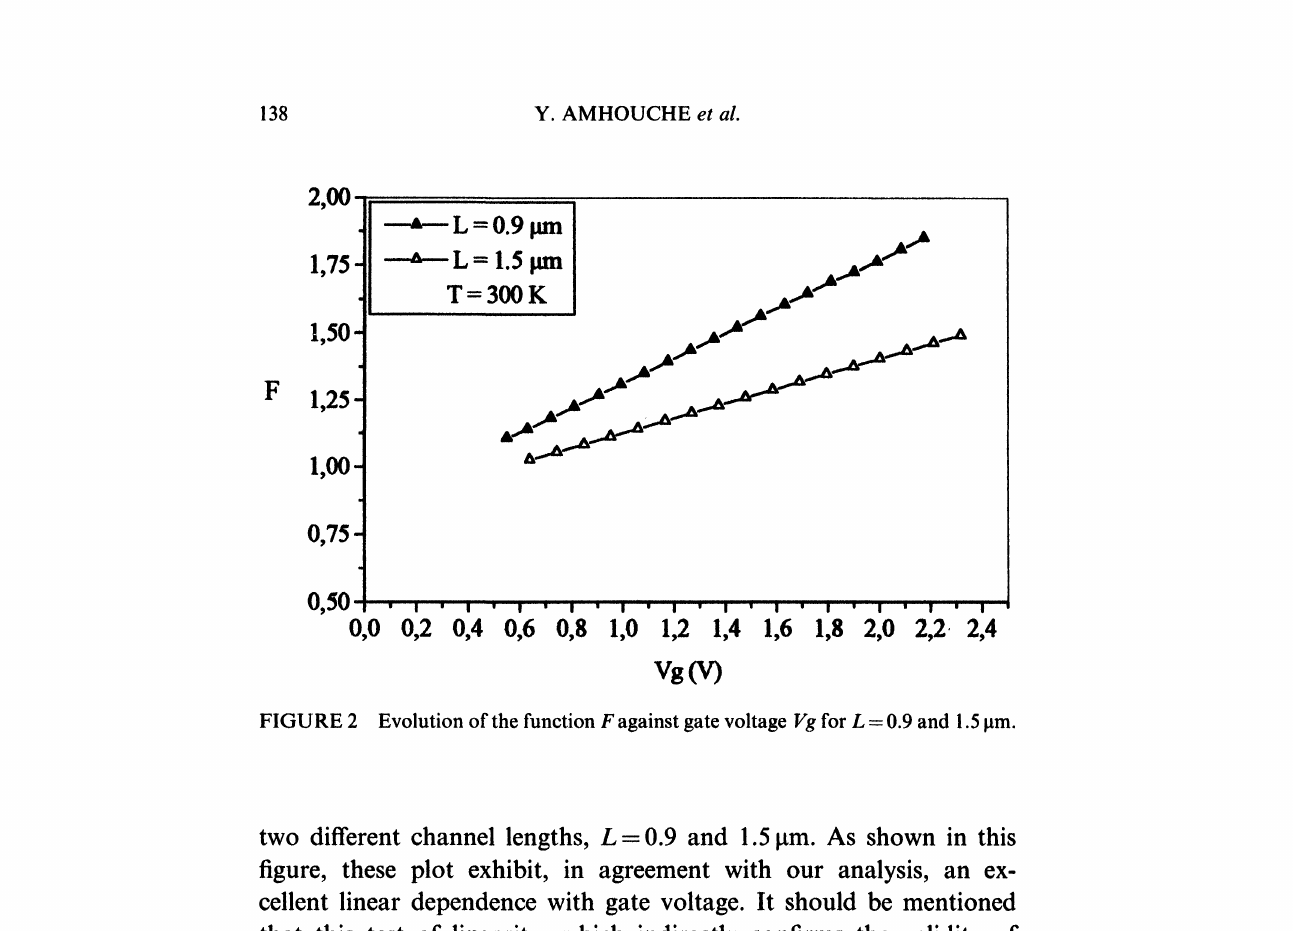
FIGURE 2 Evolution of the function F against gate voltage Vg for L -0.9 and 1.5